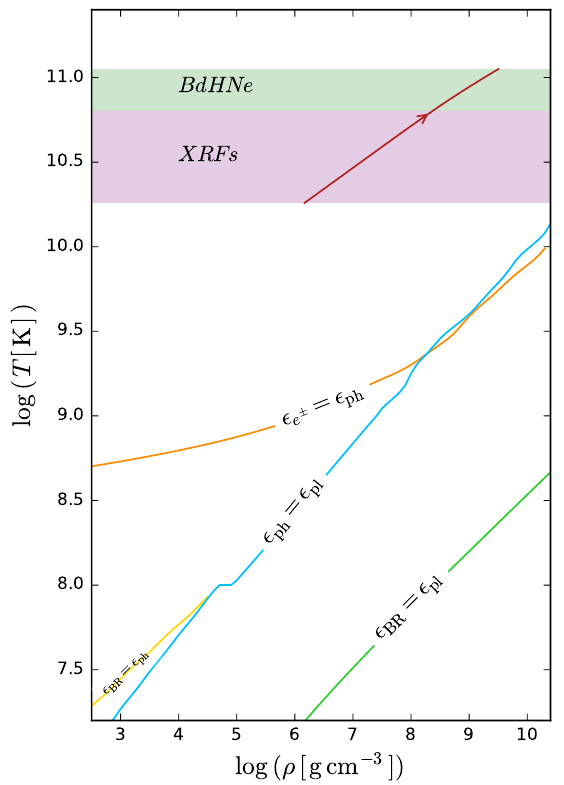
Figure 7. Temperature-density reached by the accreting atmosphere (taken from Figure 16 in [52]). The contours indicate where the emissivity of the different neutrinos processes becomes quantitatively equal to each other. We considered the following processes: pair annihilation ( (cid:101) e emission ( (cid:101) γ ), plasmon decay ( (cid:101) pl ) and Bremsstralung emission ( (cid:101) BR ). The solid red curve spans T values corresponding to accretion rates from 10 − 8 to 10 − 1 M